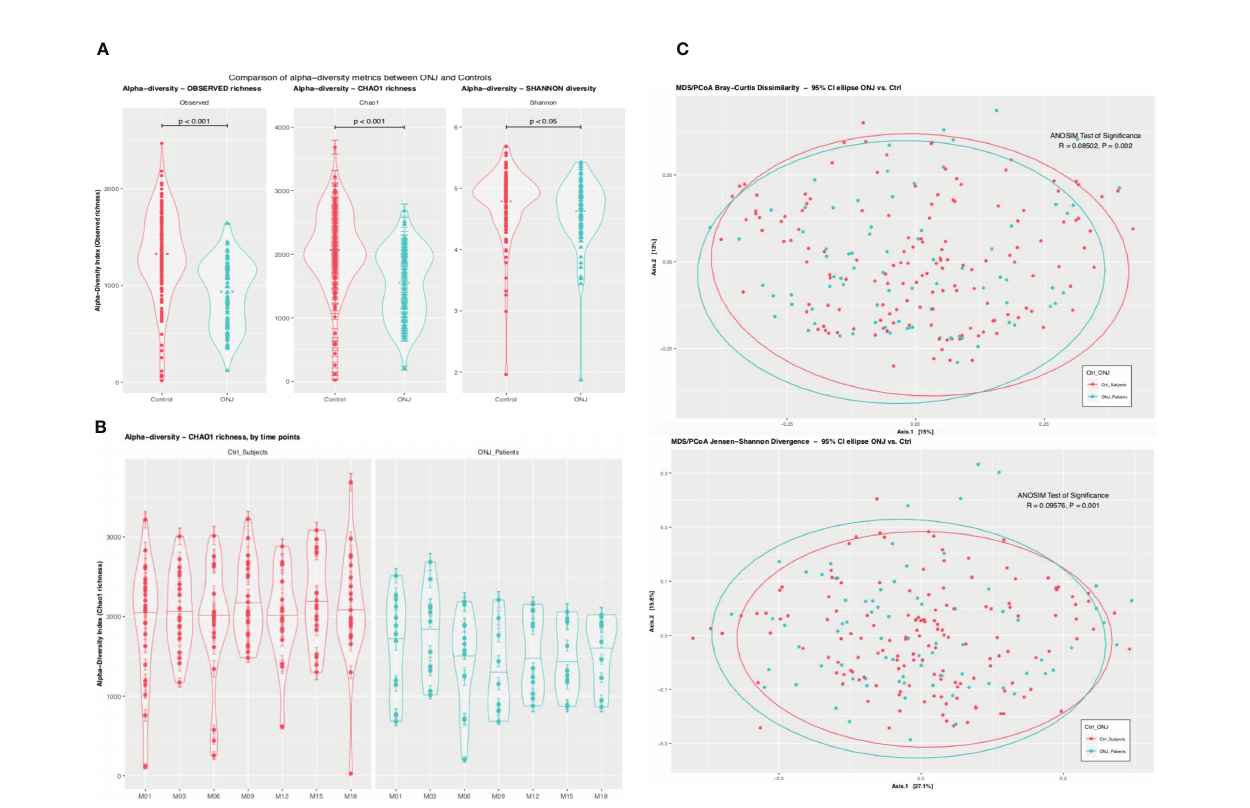
FIGURE 1 | (A) Comparison of Alpha Diversity Metrics Between BRONJ and Control. Violin plots comparing the alpha-diversity metrics for richness (Observed and Chao1) and diversity (Shannon) between control (red) and BRONJ (blue). The graphs show signi fi cantly lower richness and diversity in BRONJ patients. The signi fi cance of difference was calculated using Kruskal-Wallis test with Conferroni correction. (B) Comparison of Alpha Diversity (Chao1 Richness) Between BRONJ and Control across study time points. (C) Principal coordinate analysis (PCoA) of oral cavity microbiota using Bray – Curtis dissimilarity matrix (top) and Jensen Shannon Divergence (bottom). Two-dimensional PCoA was used to describe the relative abundance of oral microbiota. Each point represents a single sample and is colored red for controls and blue for